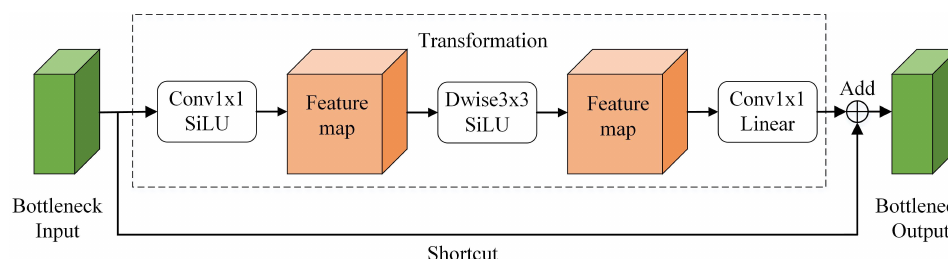
Figure 2. The structure of linear bottleneck inverse residual block.